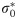
ABM simulations describing evolution of division rate variability match results for polyclonal K562 cell line.A–B Maximum Likelihood estimator (ℓ) based on the percentage of clones lost (A), on the Gini coefficient (B), and on both metrics (C) for a range of initial division rate SDs (σ0*) and mutation SDs (σm*). Note that we plot −ℓ in these plots and thus its minimum value is sought. D–E comparison of clone loss (D) and clonal dominance (E) observed in simulations with the best fitting parameter values for the Gini coefficient (red rectangle in B) and in the experiments with polyclonal K562 cells. F Comparison of the number of major clones, i.e. clones representing more than 1% of the population, developing in simulations with the parameter set highlighted by the red rectangle in B and in the experiments with polyclonal K562 cells. G Evolution of the mean division rate with the best fitting parameter values for the Gini coefficient. All simulation results are the mean of 10 simulations and the results for the polyclonal K562 cells are the mean of 3 replicates, with the error bars or colored areas representing the SD.